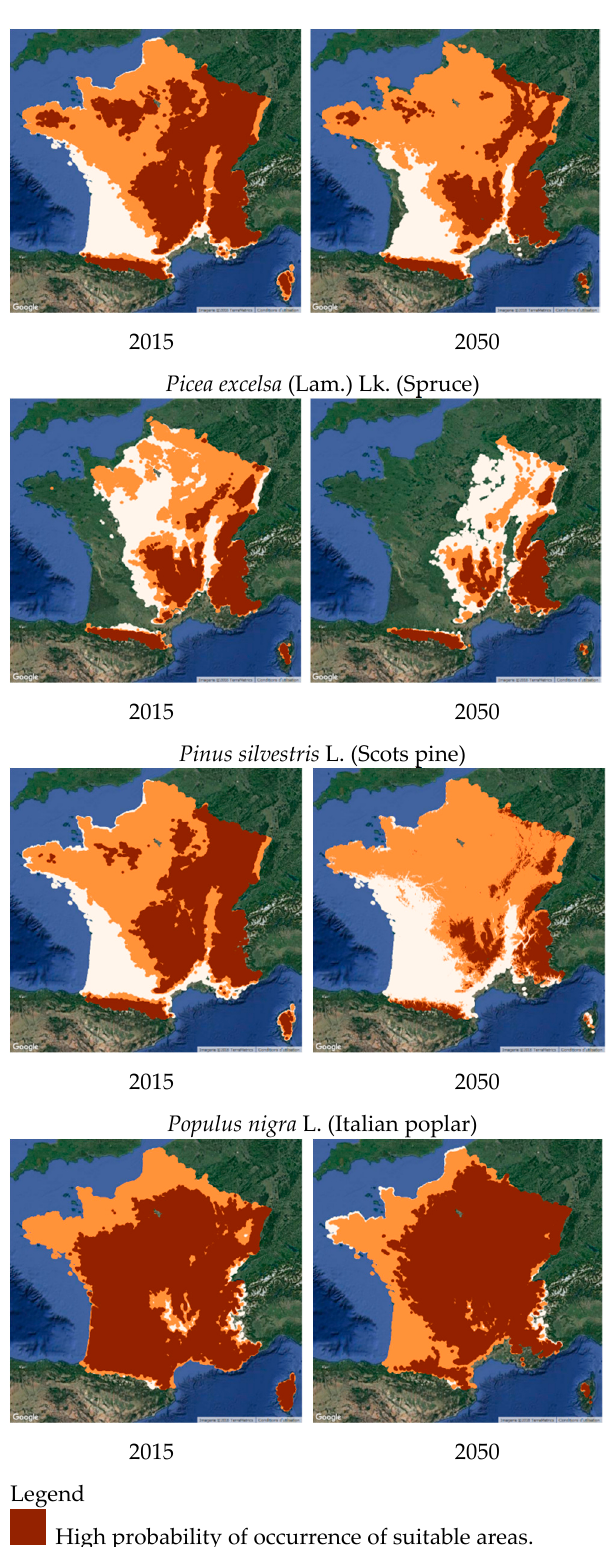
Figure 3. Potential distribution of suitable areas for the five species in 2015 and 2050.